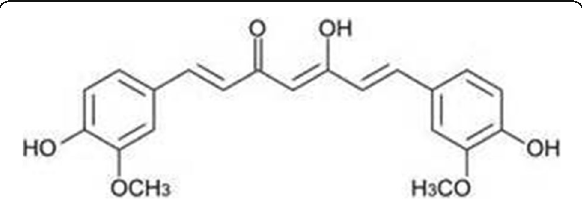
Fig. 3 Chemical structure of Cumin